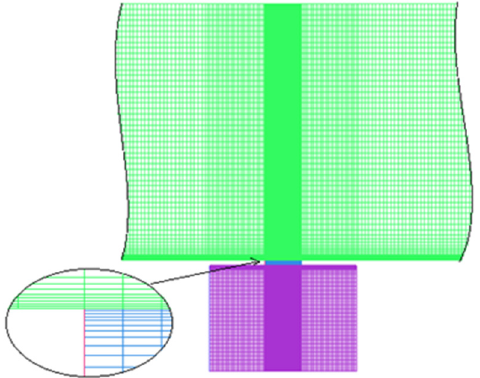
Figure 2. Partial grids along the longitudinal symmetry plane and prism layer .